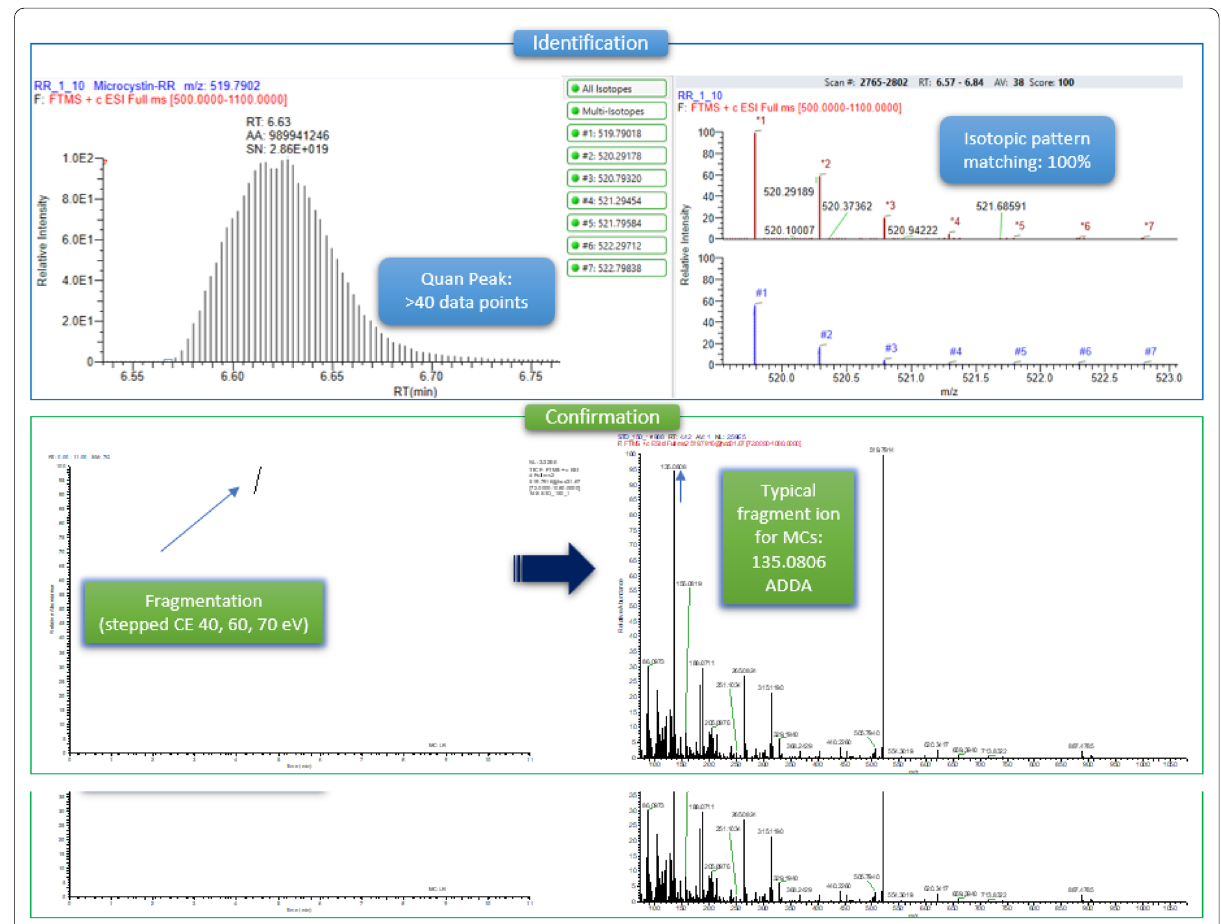
Fig. 2 Visualization of the applied steps for the identification and confirmation of